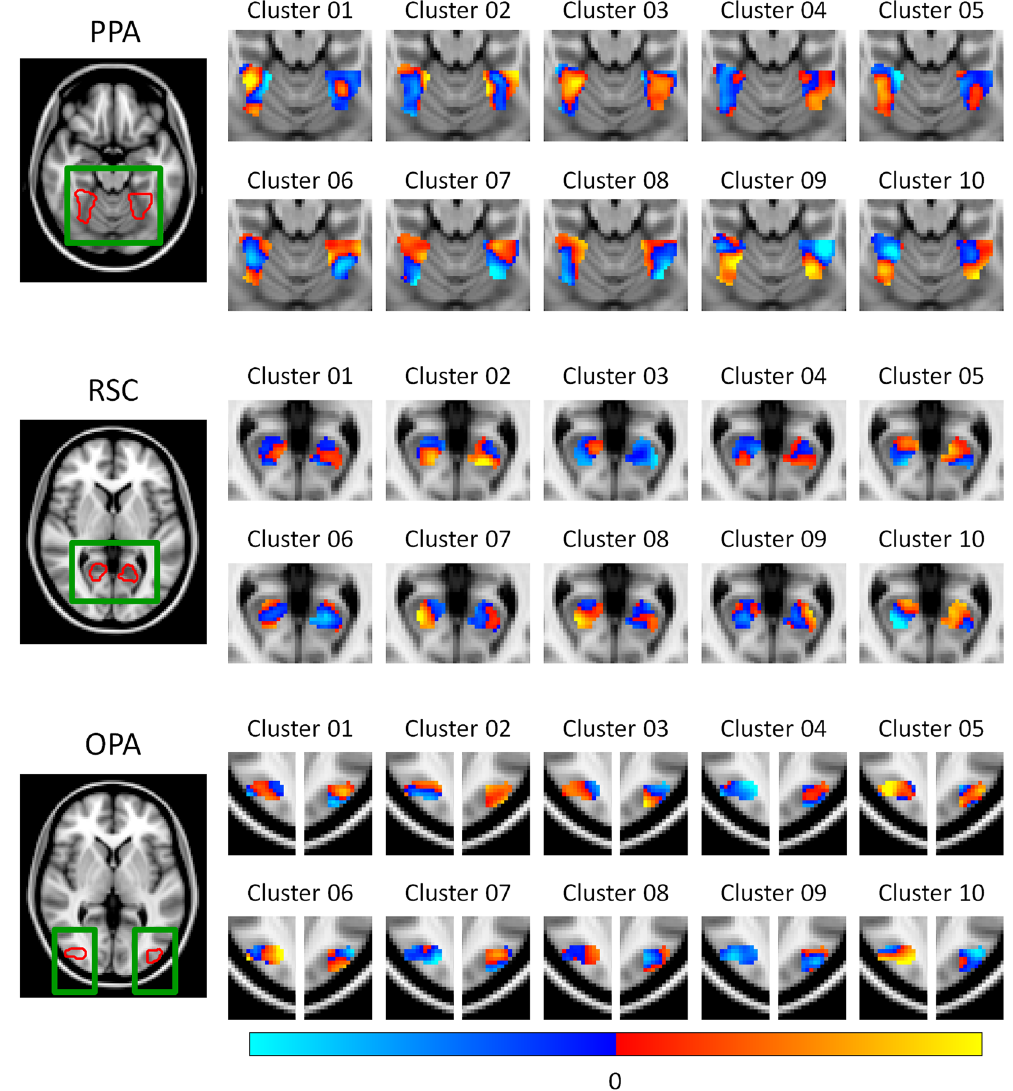
Figure 2. Group patterns of response restricted to each of the scene-selective regions (PPA, RSC, OPA). Responses are normalized by subtracting a voxel-wise mean across all conditions, such that red and blue colours indicate values above and below the mean response